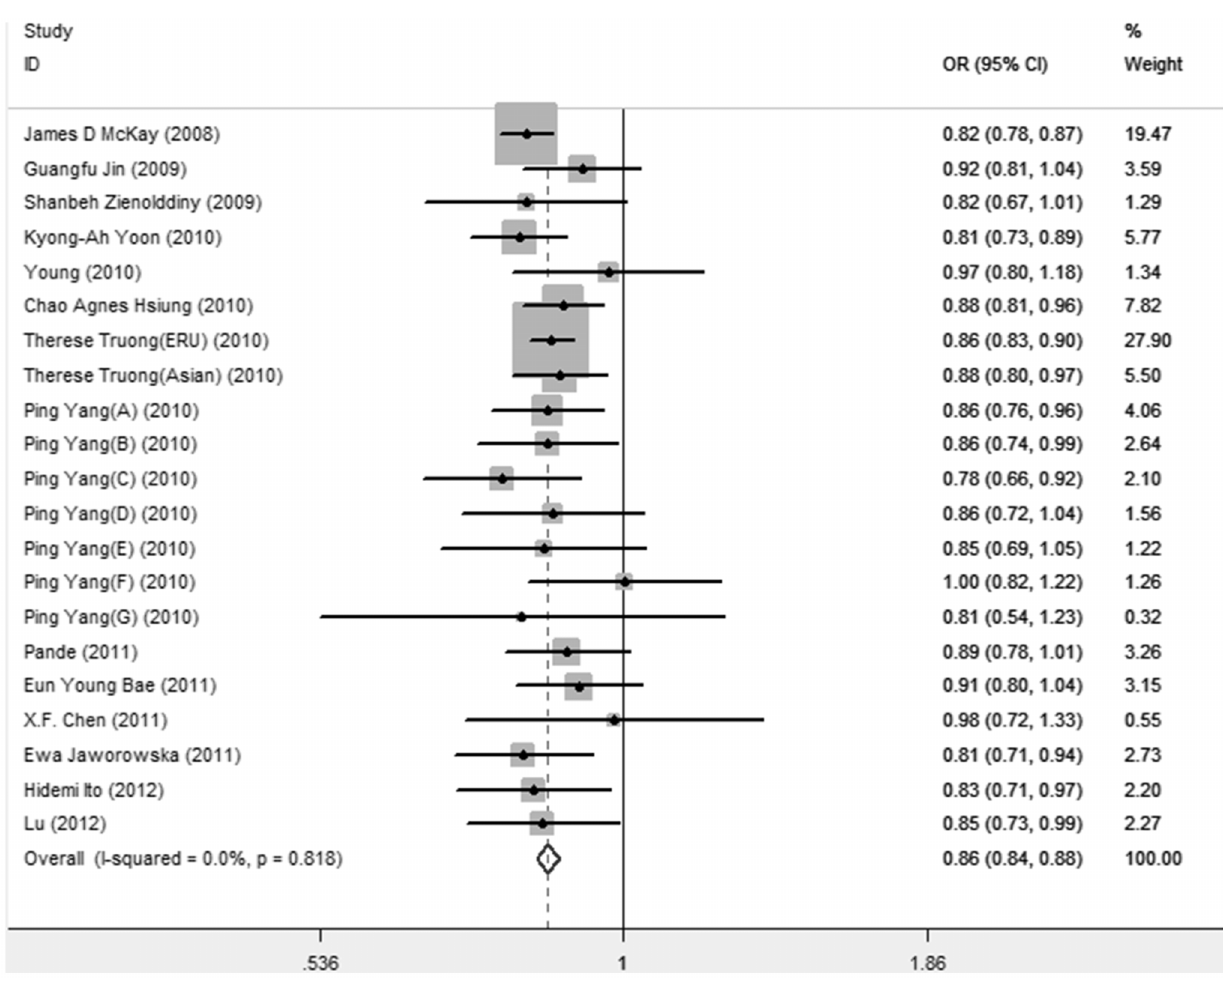
Figure 1. Forest plot of association of rs402710 with lung cancer under allelic model.